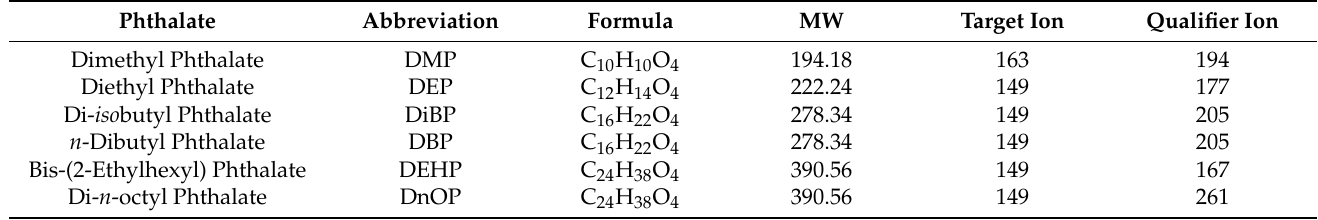
Table 1. Phthalates investigated in this paper, along with their corresponding abbreviations, formulae, molecular weight (MW), and target and qualifier ions.